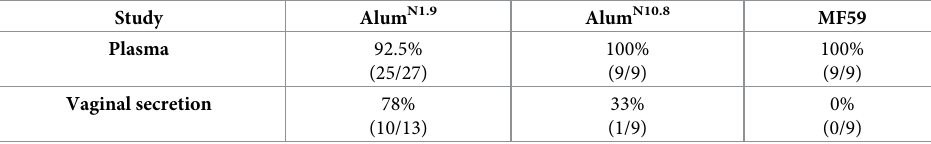
Table 2. Frequency of systemic and mucosal IgG recognition of V2 peptide 53.